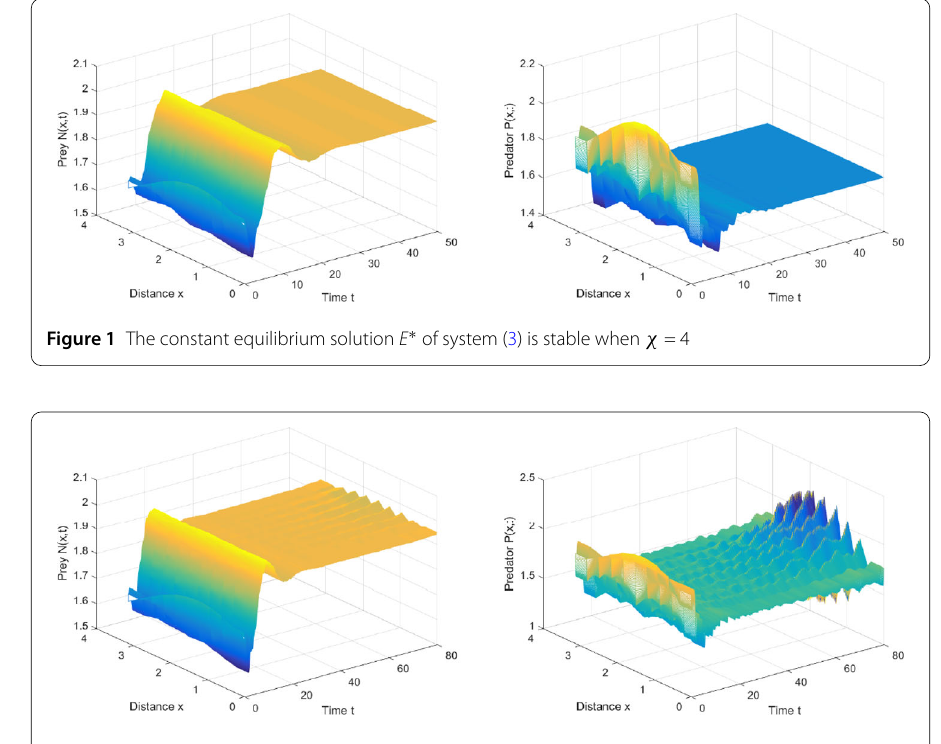
Figure 2 The constant equilibrium solution E ∗ of system (3) is unstable when χ =